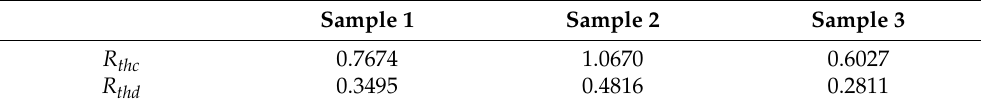
Table 2. Thermal resistances of U-shaped corrugated SWTLs (unit: m ◦ C/W).